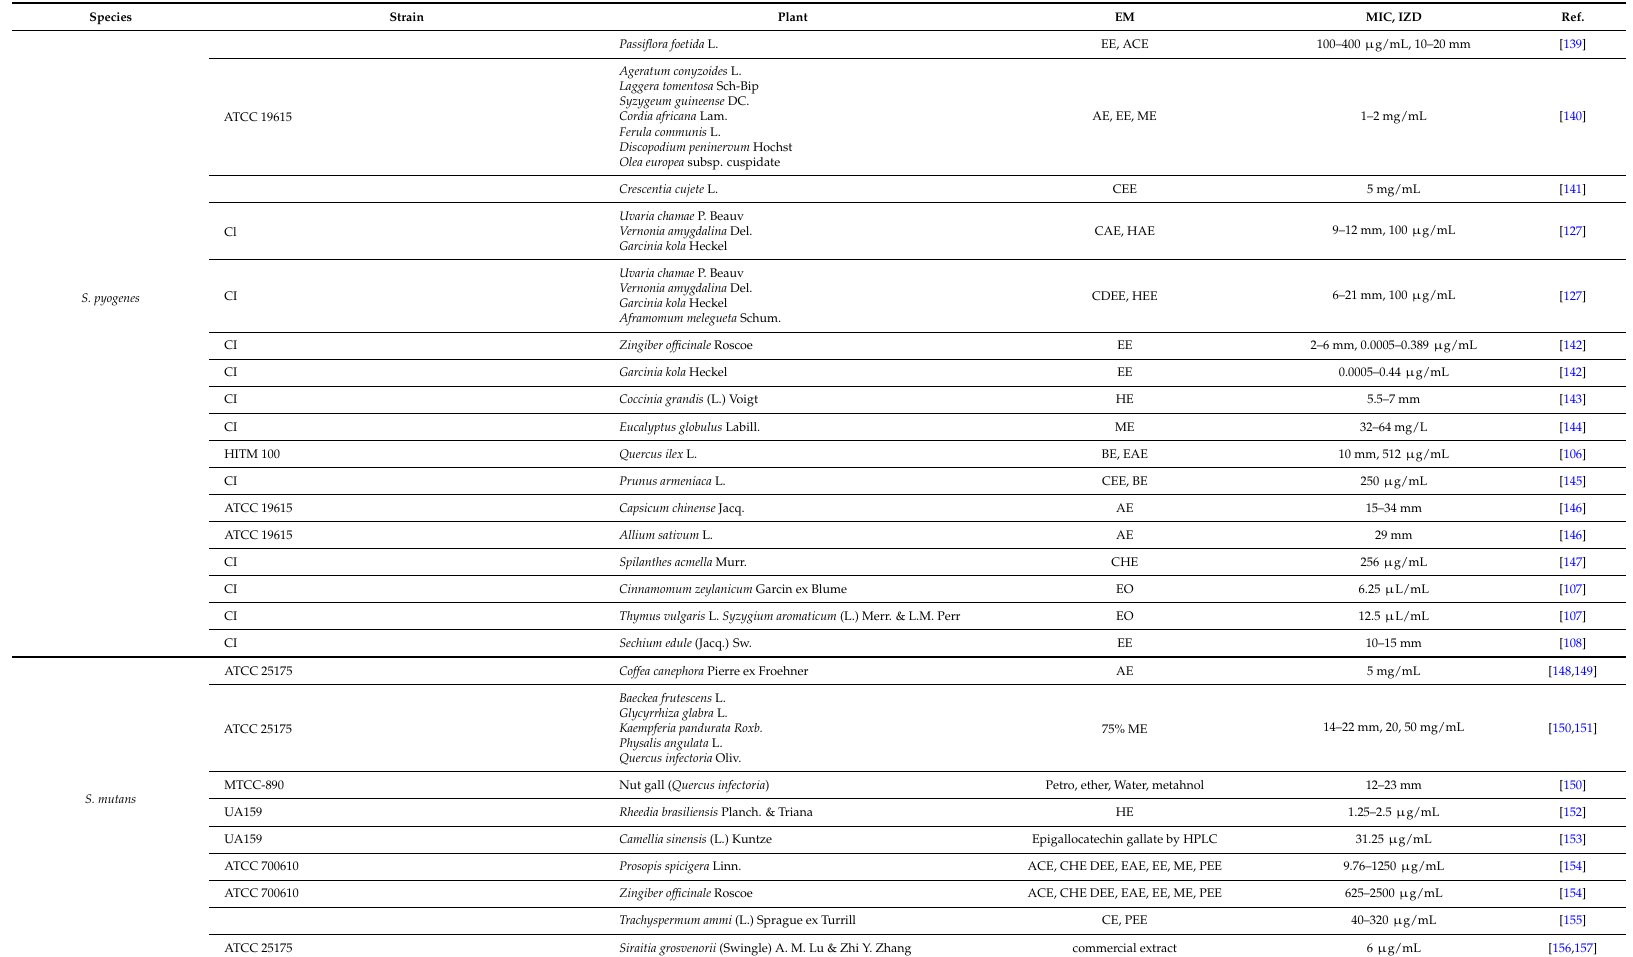
Table 3. Inhibitory effects of phytochemicals against selected Streptococcus